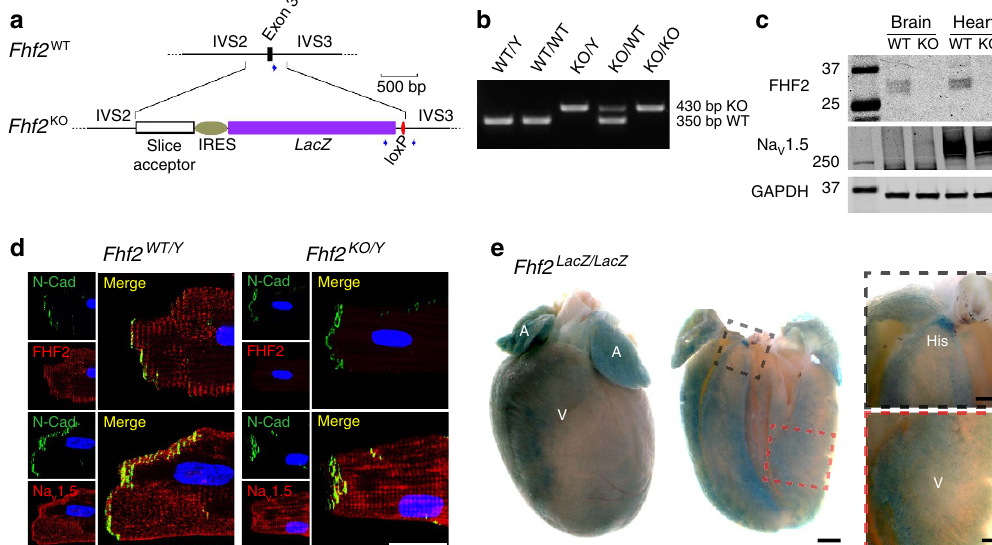
Figure 1 | Derivation and validation of Fhf2 KO mice. ( a ) Schematic of Fhf2 WT and Fhf2 KO alleles. The Fhf2 KO allele differs from the Fhf2 WT allele by the replacement of a 570-base genomic segment spanning coding exon 3 with a cassette containing splice acceptor site, internal ribosome entry site, a b -galactosidase coding sequence and residual loxP site. Positions and orientations of three PCR primers are indicated (blue arrowheads). ( b ) PCR genotyping of Fhf2 WT and Fhf2 KO alleles. Simultaneous amplification of wild-type 350bp and mutant 430bp allelic segments were resolved on agarose gel. ( c ) Immunoblotting of Fhf2 WT/Y and Fhf2 KO/Y tissue extracts. 40mcg protein from Triton X-100-soluble fractions of brain and heart lysates were electrophoresed and immunoblotted to detect FHF2 (top), Na V 1.5 (middle) and GAPDH (bottom). The prominent B 30kDa species in Fhf2 WT/Y heart corresponding to the FHF2VY isoform are not detected in Fhf2 KO/Y samples. ( d ) Immunofluorescence detection of FHF2 and Na V 1.5 in Fhf2 WT/Y and Fhf2 KO/Y cardiomyocytes. Dissociated cells were fixed and probed with antibodies to FHF2 (red), Na V 1.5 (red) and N-cadherin (green) along with DAPI nuclear stain (blue). FHF2 and Na V 1.5 colocalize to Fhf2 WT/Y striated T-tubules. Na V 1.5 is comparably localized in the Fhf2 KO/Y myocyte, while FHF2 is not detected. ( e ) Whole-mount X-Gal staining of a Fhf2 LacZ/LacZ heart. LacZ at native sites of Fhf2 expression in targeted alleles ( a ) was detectable throughout the heart, including atria (A), ventricles (V) and bundle of His (His). Higher magnification views of His bundle (black dashed box) and the left ventricular free wall (red dashed box). Scale, 25 m m ( d ); 1mm ( e , left); 250 m m ( e ,